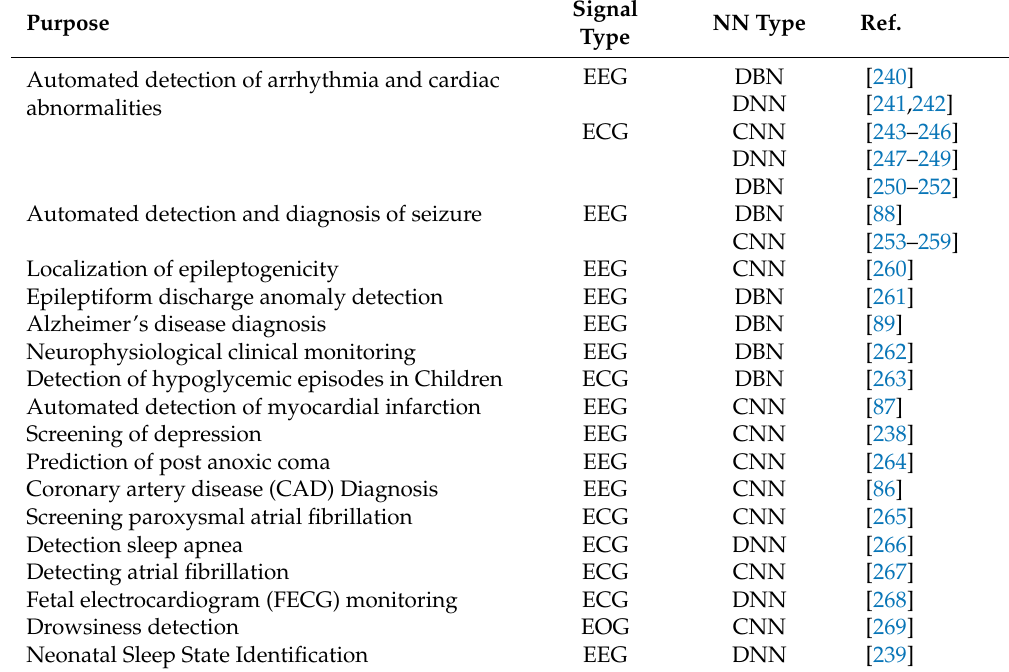
Table 5. Overview of papers using deep learning techniques for Diseases Diagnosis.